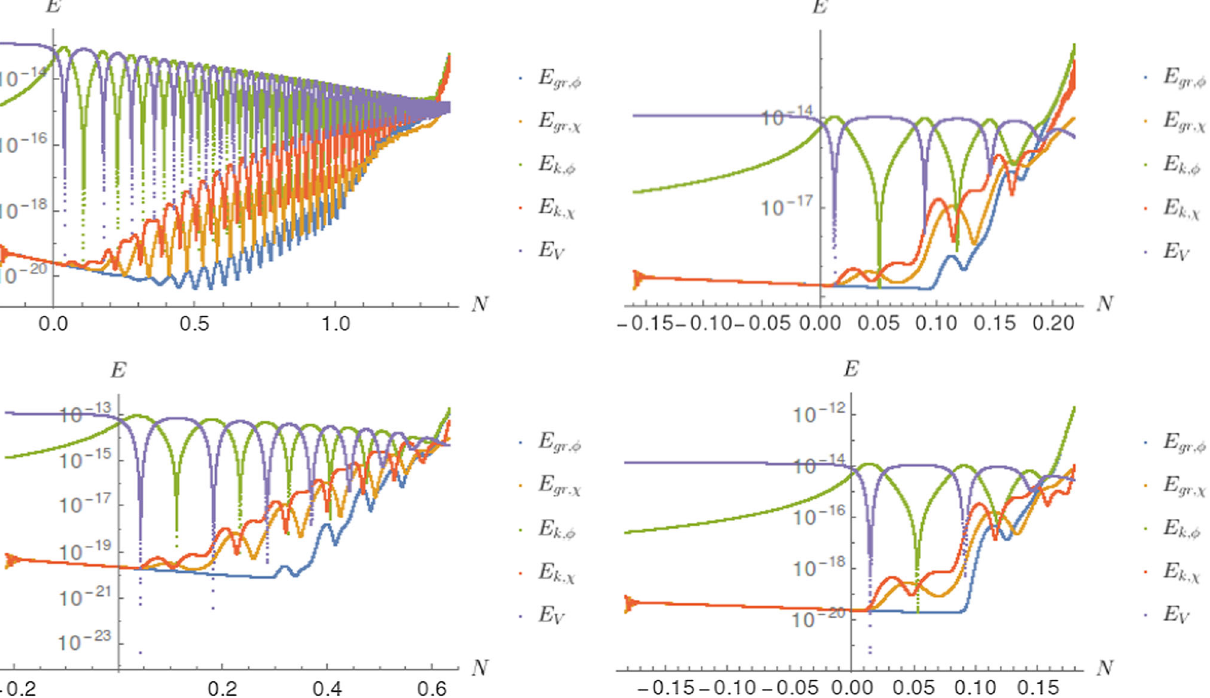
Fig. 15 The evolution of the components of the energy density for n = 1 , α = 10 − 3 (upper left), n = 1 , α = 10 − 4 (upper right), n = 1 . 5 , α = 10 − 3 (lower left), n = 1 . 5 , α = 10 − 4 (lower right). N is the number of e-folds after the end of inflation. These results were obtained on a lattice with N lattice =